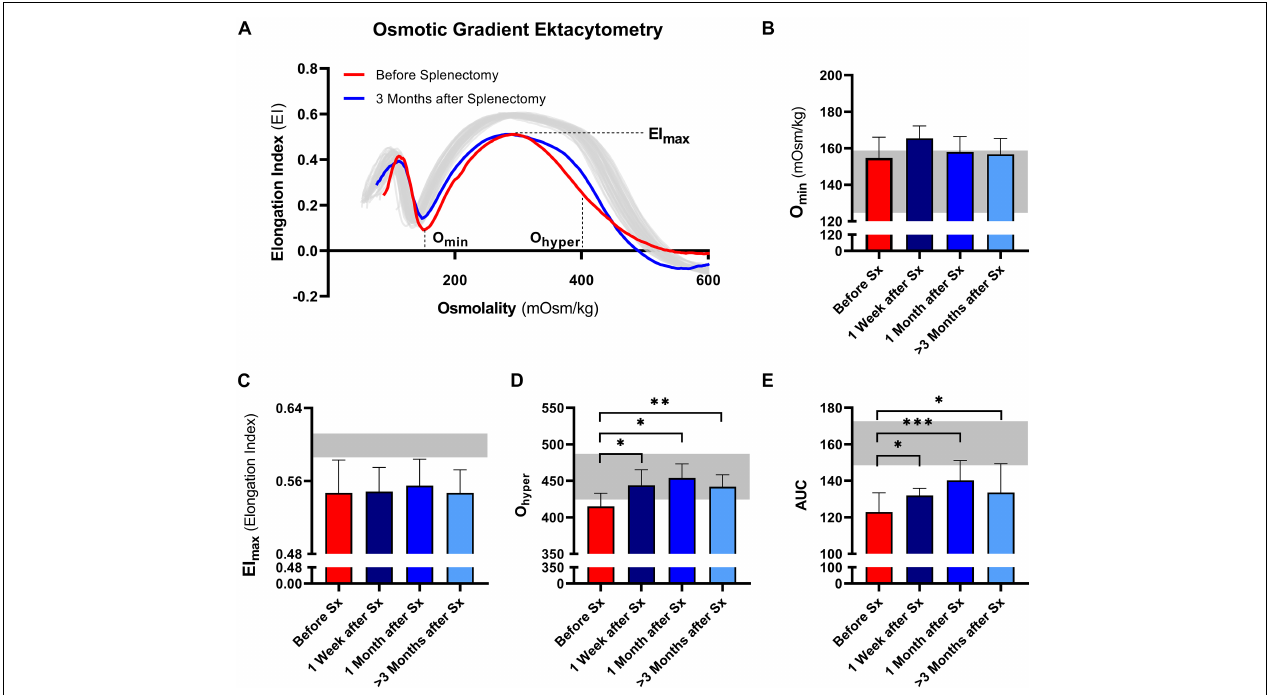
FIGURE 2 | Osmotic gradient ektacytometry curve (Osmoscan) and the corresponding parameters of 5 patients with HS before and after splenectomy (Sx). (A) Representative example of the osmotic gradient ektacytometry curve in P03 before and 3 months after splenectomy. The osmotic gradient ektacytometry curves of healthy controls ( n = 40) are depicted by the gray lines. The changes in (B) the surface area to volume ratio of red blood cells (Omin), (C) the maximum deformability (EImax), (D) the hydration state or cytoplasmic viscosity (Ohyper) and (E) the area under the curve (AUC) are depicted above. The HS patients ( n = 5) were grouped and the results are displayed as the mean (SD) of the combined values. The mean (2SD) of healthy controls ( n = 74) are depicted in the light gray area (B–E) . Error bars represent standard deviation. *** p < 0.001, ** p < 0.01, * p ≤